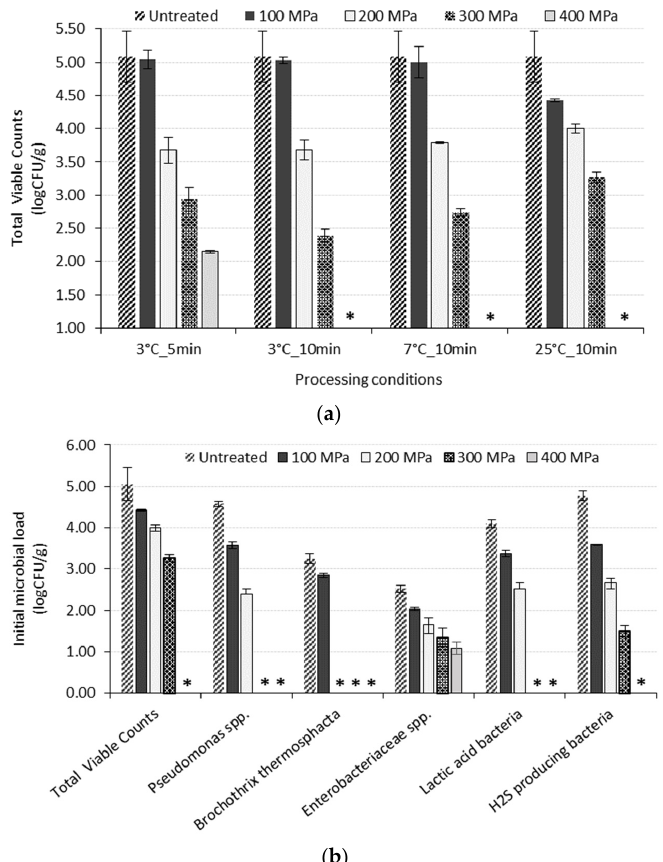
Figure 1. ( a ) Initial microbial load of untreated European sea bass fillets and after HP processing at different pressure–temperature–time conditions. ( b ) Microbial load of all tested microorganisms of untreated European sea bass fillets and after HP processing at different pressures and 25 °C for 10 min. Symbol (*) refers to non-measurable levels of microorganisms, i.e., <2.0 log CFU/g for TVC, Pseudomonas spp., and Brochothrix thermosphacta or <1 log CFU/g for Enterobacteriaceae spp., LAB, and H 2 S producing bacteria. Each bar shows the mean and the standard deviation of four replicates ( n